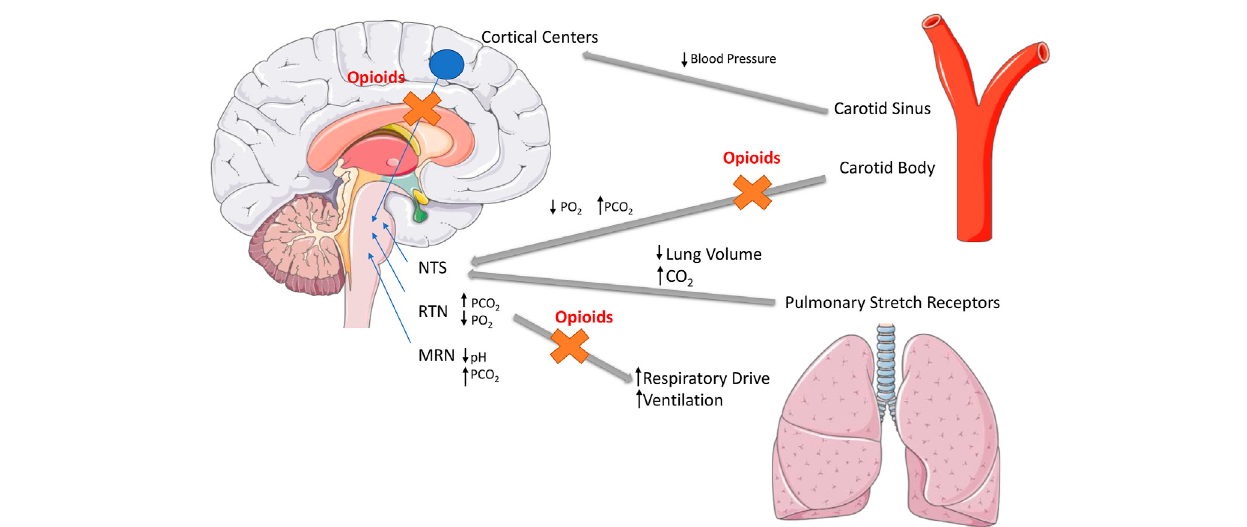
FIGURE2| Opioid-inducedrespiratorydepressionmechanisms.Opioid-inducedanalgesiaandrespiratorydepressionarisefromstimulationof μ -opioidreceptors (MORs). MORs are expressed in neurons involved in the control of breathing, primarily located in the brainstem, particularly in the Nucleus Tractus Solitarius (NTS), Retrotrapezoid Nucleus (RTN) and Median Raphe Nuclei (MRN) (Boom et al.,